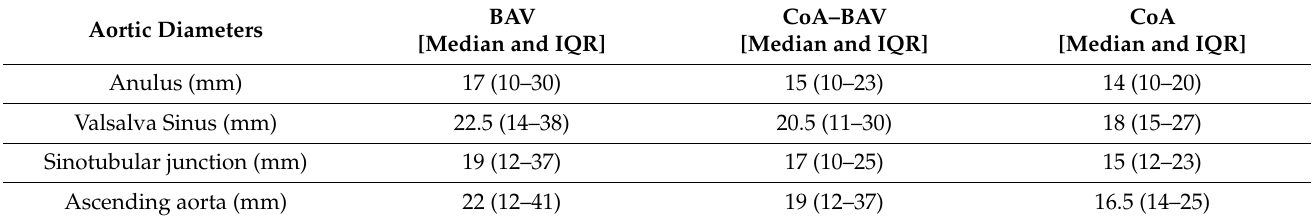
Table 2. Aortic size at annulus, sinus of Valsalva, sinotubular junction, and proximal ascending aorta level (median diameters and IQR). IQR = interquartile range; BAV = bicuspid aortic valve; CoA = aortic